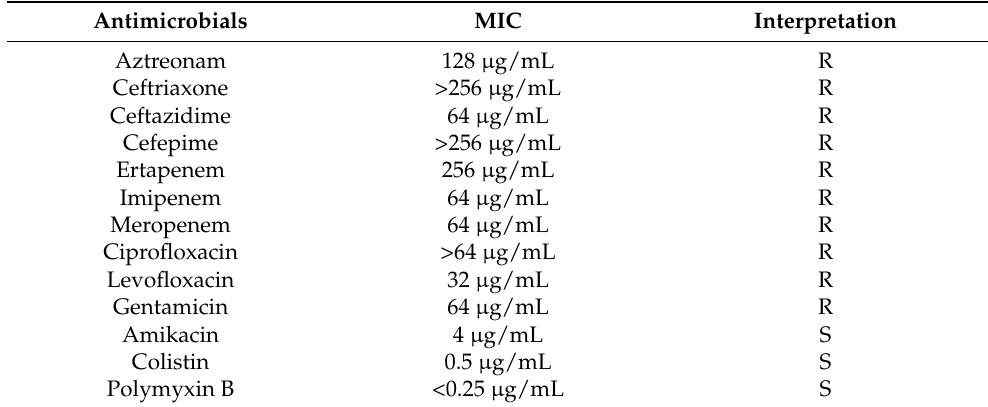
Table 1. Minimum inhibitory concentrations (MIC) of the isolate KP411 recovered from a poultry farm in the city of Castanhal, Brazil. Antimicrobials MIC Interpretation Aztreonam 128 µ g/mL R Ceftriaxone >256 µ g/mL R Ceftazidime 64 µ g/mL R Cefepime >256 µ g/mL R Ertapenem 256 µ g/mL R Imipenem 64 µ g/mL Meropenem Levofloxacin 32 µ g/mL Gentamicin 64 µ g/mL Amikacin 4 µ g/mL Colistin 0.5 µ g/mL Polymyxin B <0.25 µ g/mL